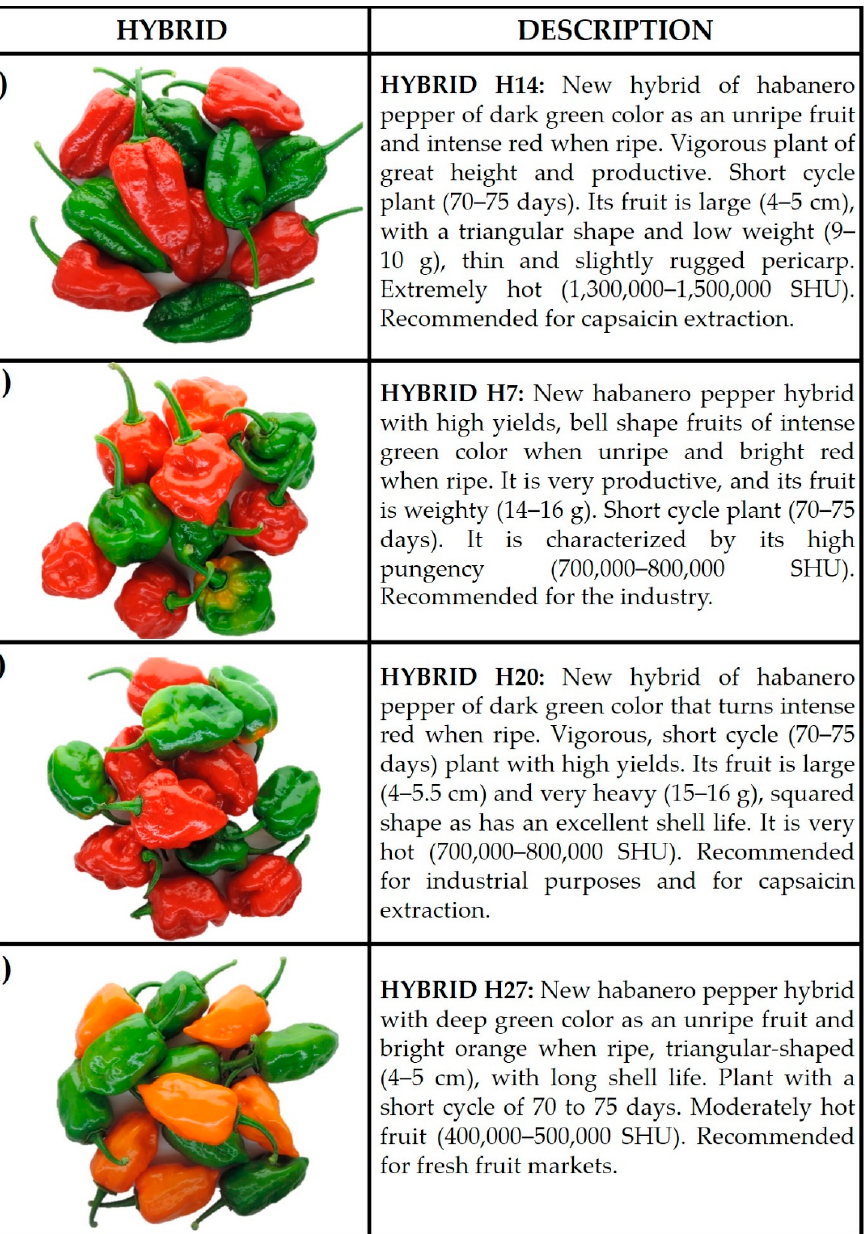
Figure 6. F1 hybrids ( a ) H14, ( b ) H7, ( c ) H20 and ( d ) H27 were selected because of their high productivity potential and high hotness.